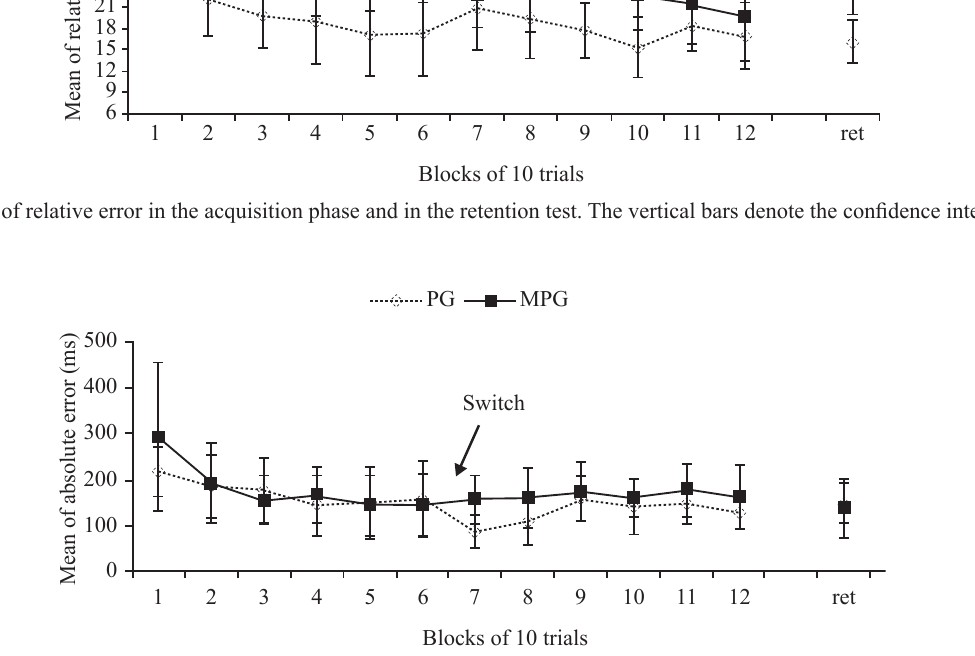
Figure 2. Mean of absolute error in the acquisition phase and in the retention test. The vertical bars denote the confidence interval in 95%.